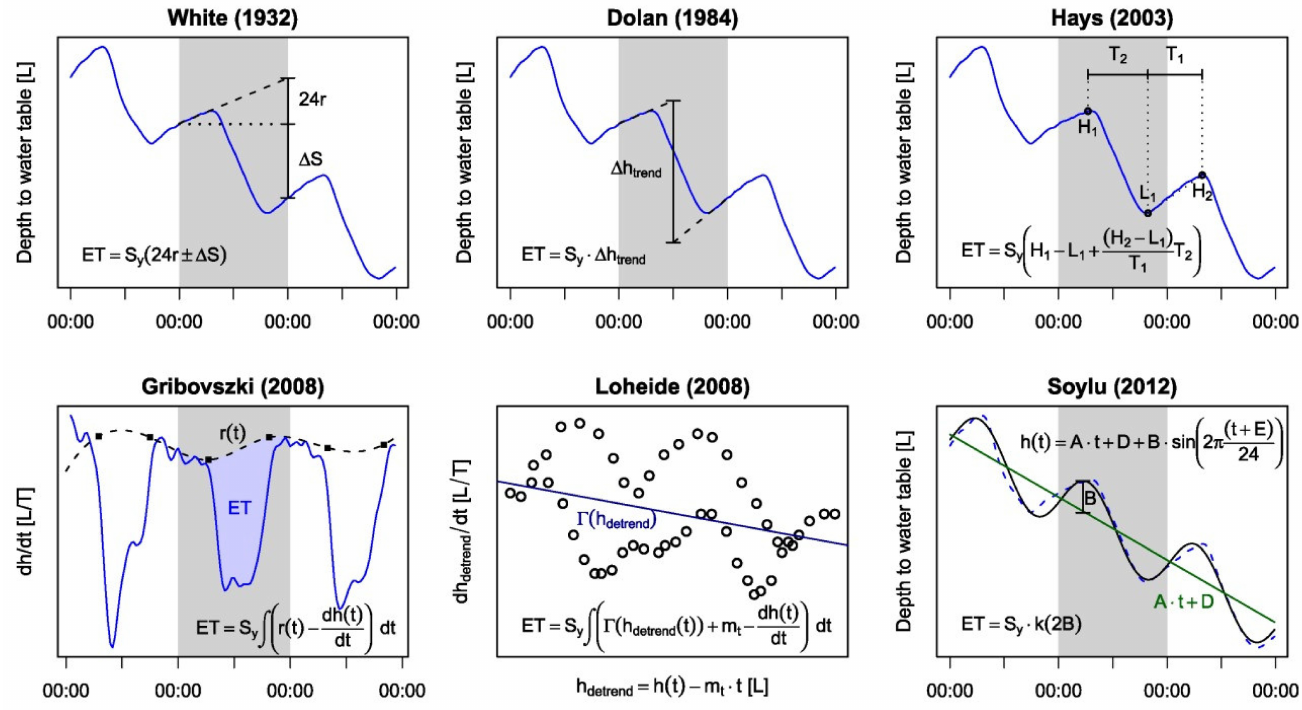
Figure 1. Computational schematic of the White method and its improved approaches